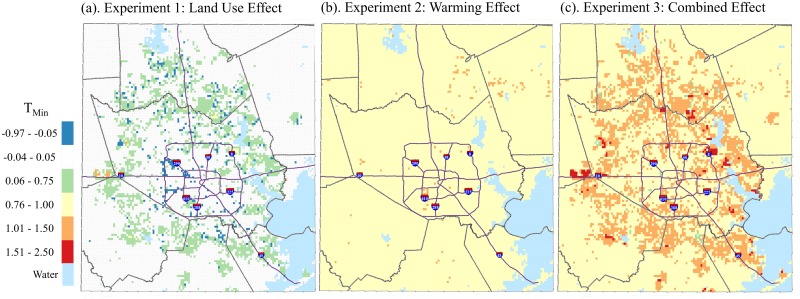
Simulated May-September median HImax differences between (a) Future Land Use, Δ 0°C and Present Land Use, Δ 0°C; (b) Present Land Use, Δ 1°C and Present Land Use, Δ 0°C; (c) Future Land Use, Δ 1°C and Present Land Use, Δ 0°C, 1-km grid, Houston study area.